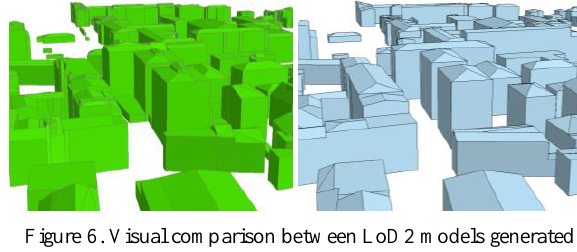
Figure 6. Visual comparison between LoD2 models generated using LiDAR data and different cartographic maps: on the left using 1:1,000 map and on the right using 1:10,000 map. DTM automatically obtained by photogrammetric DSM is usually noise-affected and it has several discrepancies with